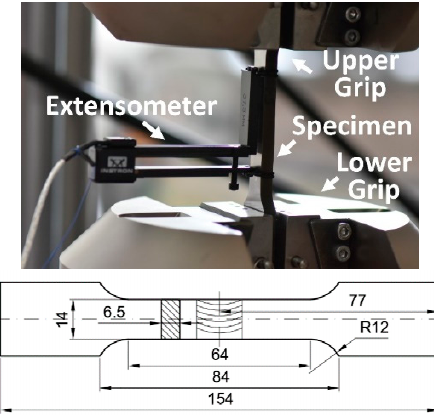
Figure 1. Flat specimen with weld in grips and its engineering drawing.